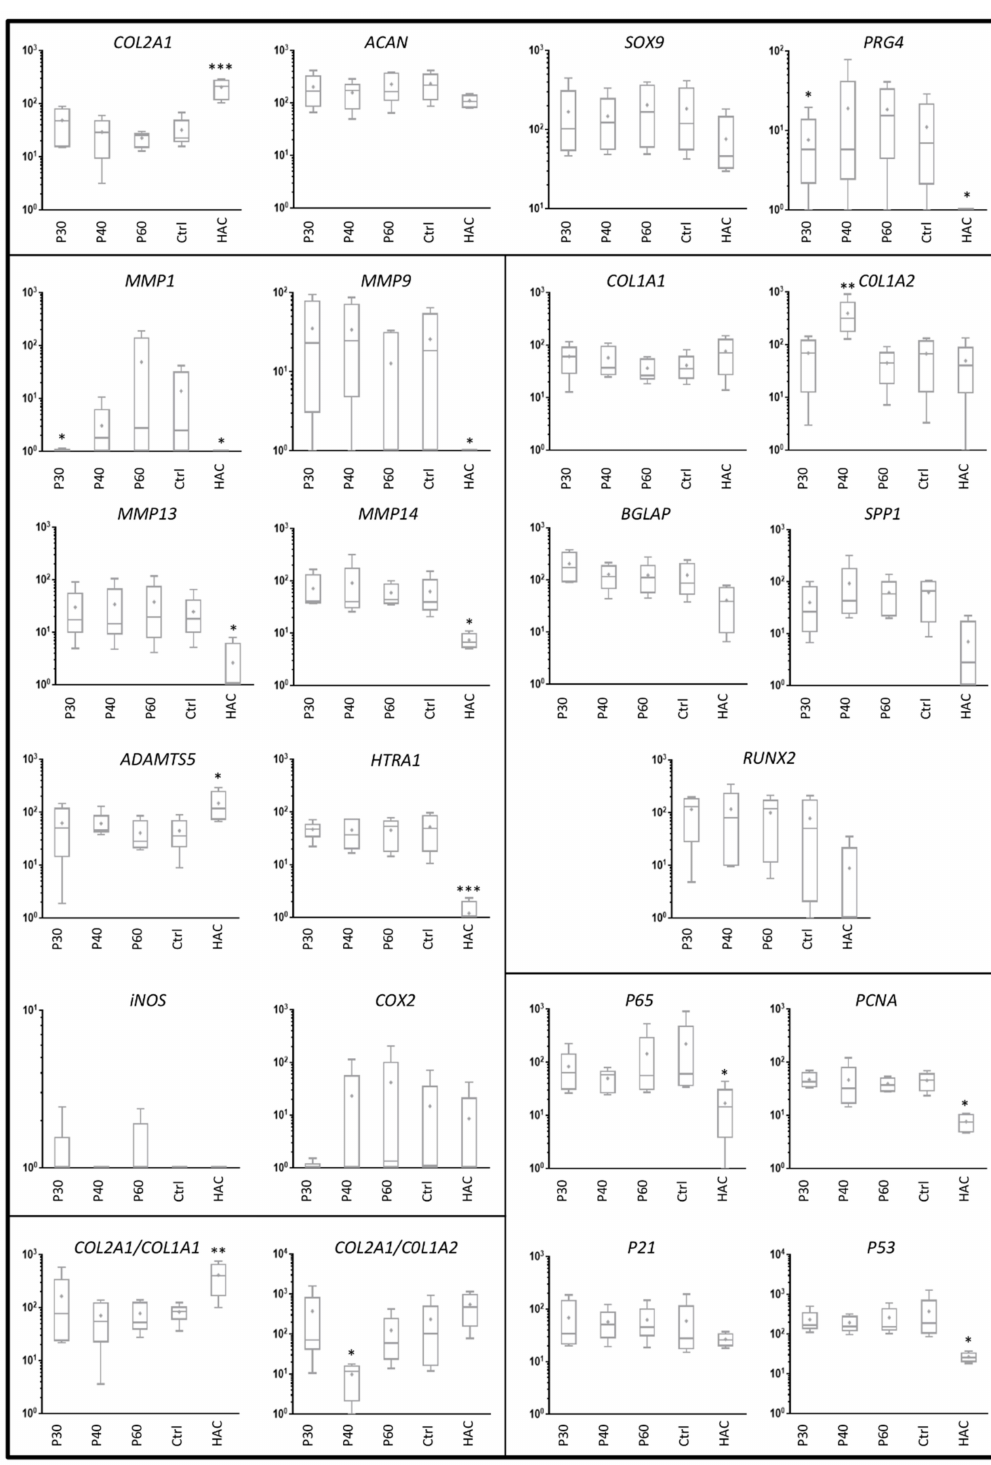
Figure 6. Effect of high concentrations of Promerim ® 30, 40 and 60 on gene expression profile in human articular chondro- cytes. Human articular chondrocytes were grown in type I/III collagen sponges at (P2) for 7 days in hypoxia in the absence (Ctrl: control) or presence of 50 µ g/mL Promerim ® 30, 40 or 60 (P30, P40, P60). Results are summarized in box plots ( n = 5) showing the mean (cross) and the median (line) of relative mRNA expression estimated using RT-qPCR and normalized to the β -ACTIN and PPIA reference genes. The COL2A1 : COL1A1 and COL2A1 : COL1A2 ratios are given. HAC: mRNA obtained from human articular chondrocytes at P0 were used as controls. Statistical analyses were performed using the two-way ANOVA followed by Dunnett’s multiple comparison post-test (* p < 0.05; ** p < 0.01; *** p < 0.001) compared with the control